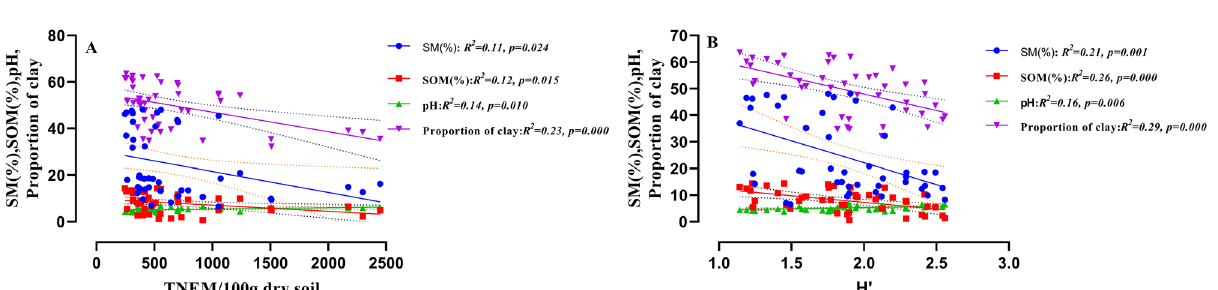
Figure 9. Relationships between four soil abiotic factors with nematode abundance ( A ) and diversity ( B ) estimated from a multiple linear regression model. Circle, square, triangle and inverted triangle represent SM%, SOM%, pH and proportion of clay respectively. R 2 , p value and doted lines representing 95% confidence interval of the best fit line are